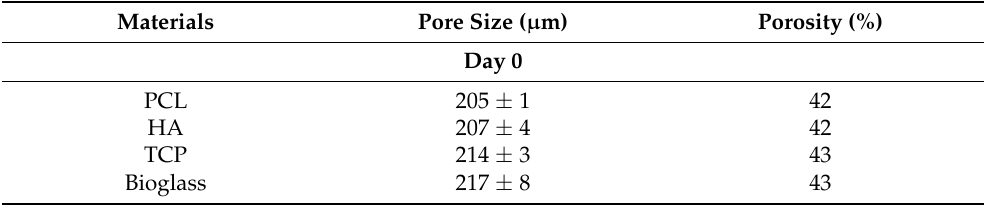
Table 2. Pore size and porosity values of scaffolds (200 µ m pore size) before and after the degradation